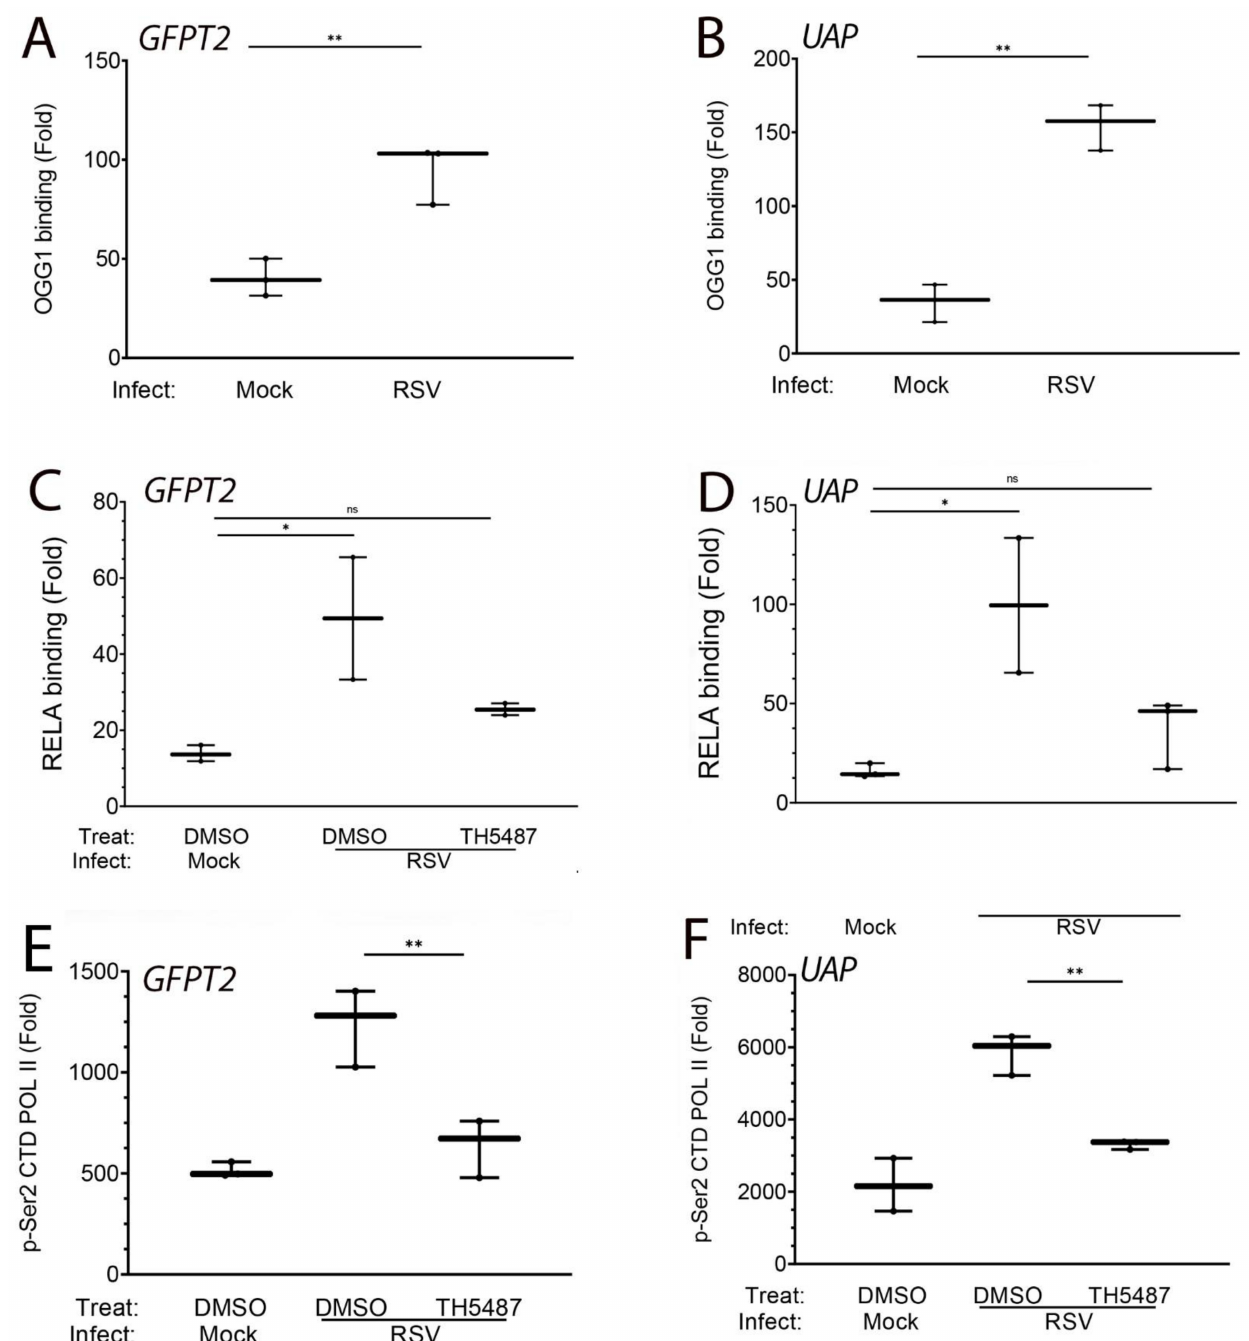
Figure 10. OGG1 inducibly binds to HBP regulatory elements and recruits phospho-Pol II. XChIP was performed on control or RSV-infected hSAECs; data are expressed as a fold change over IgG control. ( A ) OGG1 binding to the GFPT2 intragenic enhancer. ( B ) OGG1 binding to the UAP1 promoter. ( C – F ), Cells were RSV infected in the presence of solvent (DMSO) or TH5487 as indicated. ( C , D ), XChIP for RELA binding. ( E , F ), XChIP for phospho-Ser2 CTD Pol II binding. *, p < 0.05; **, p < 0.01; n.s., not significant. Each symbol is an independent